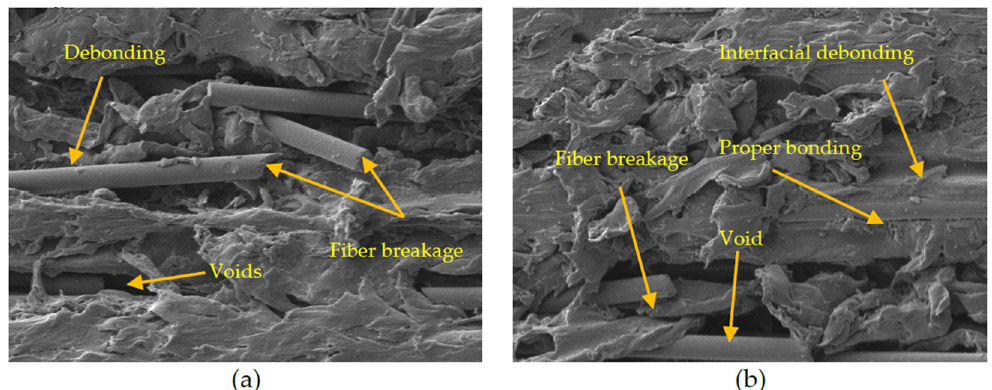
Figure 18. Micrograph of the longitudinal cross-section after bending: ( a ) low flexural strength; ( b ) high flexural strength.